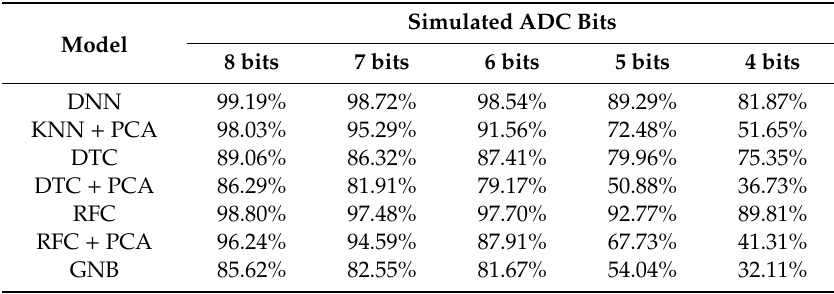
Table4. Averageinferenceaccuraciesusinglowerresolutionquantizationappliedtotrainingandtesting.